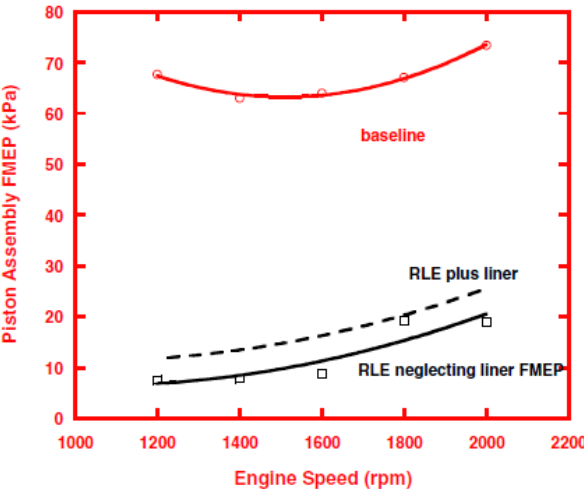
Figure 3. Hot motoring friction of the light-duty RLE compared to baseline, borrowed from Kim et al. (2005). The x axis shows the engine speed, and the y axis shows the measured motoring FMEP for the two engines. This was performed after the tear down process allowed the isolation of the piston assembly FMEP from the other terms (i.e., crankshaft, camshaft, etc.).